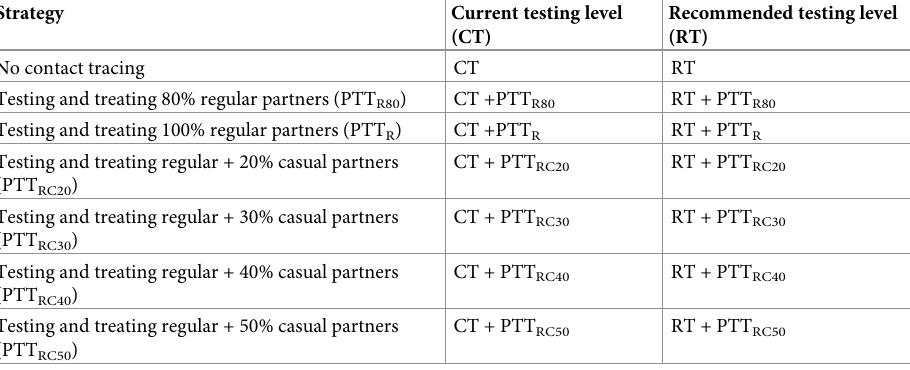
Table 2. Outbreak response strategies and notation used.